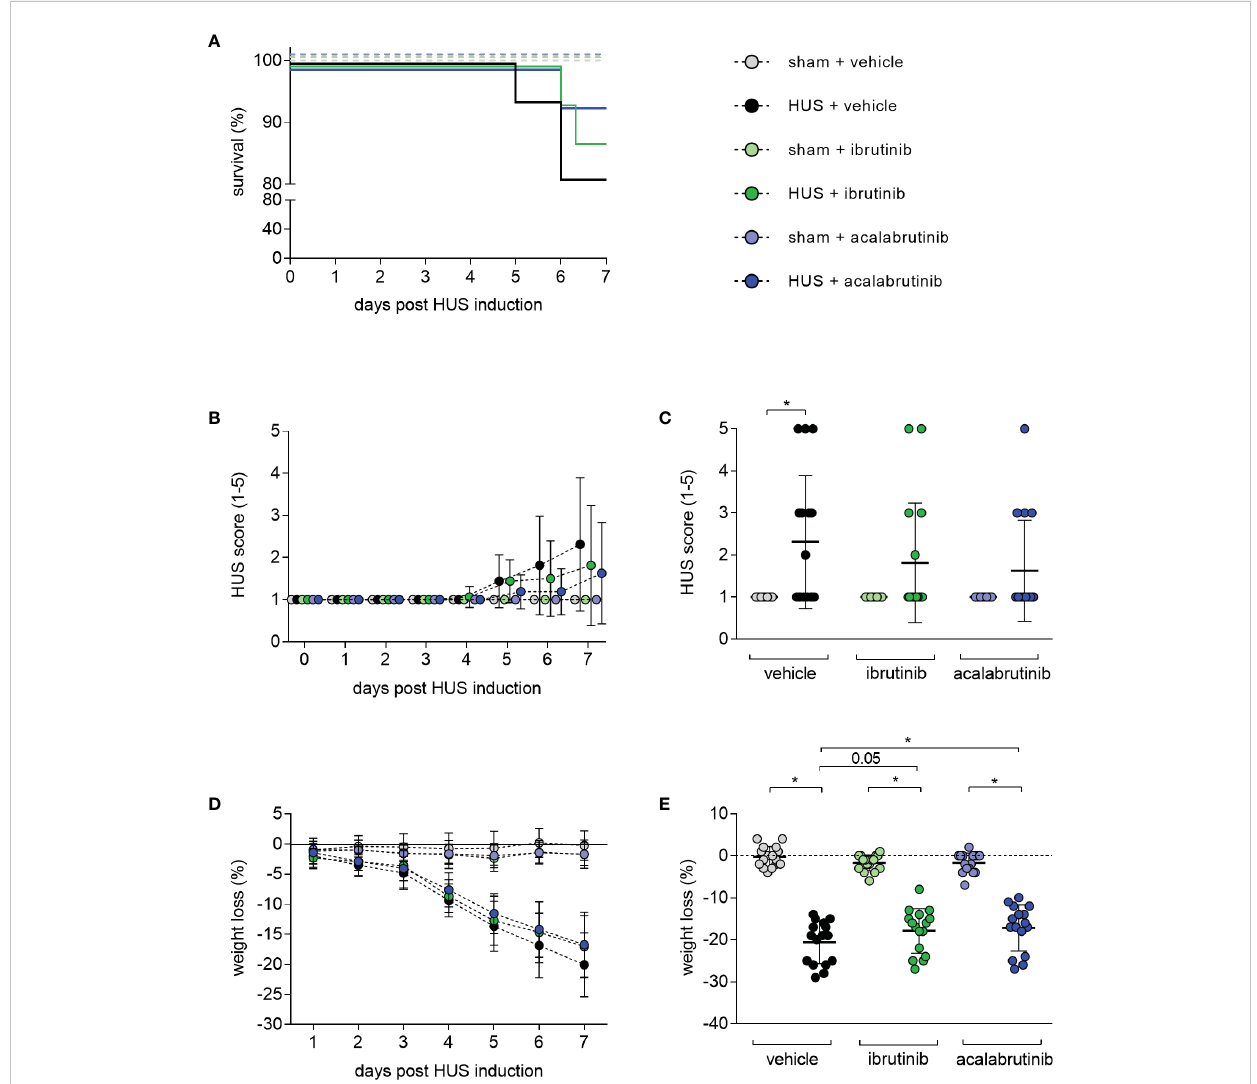
FIGURE 1 Clinical presentation of mice with HUS treated with ibrutinib or acalabrutinib. HUS followed up for 7 days in sham mice and mice subjected to HUS with daily oral application of vehicle, ibrutinib or acalabrutinib. (A) Survival by Kaplan-Meier survival analysis + post hoc test, analysis of (B) progression of HUS score in the course of the experiment (ranging from 1 = no signs of illness to 5 = dead), (C) HUS score on day 7, (D) progression of weight loss in the course of the experiment, (E) weight loss on humane endpoints or day 7 (n = 16 per group). Data are expressed as (B, D) dot blot and (C, E) scatter dot blot with mean + SD. (C) Kruskal-Wallis test + Dunn ’ s multiple comparison test, (E) ordinary one-way ANOVA + Holm- Sidak ’ s multiple comparison test. *P < 0.05. HUS, hemolytic uremic